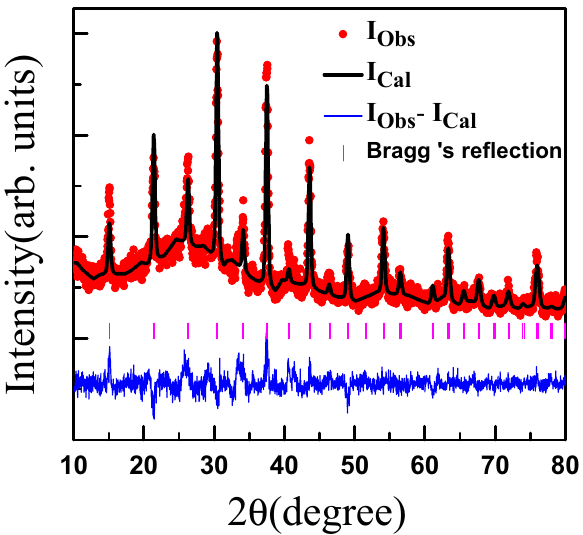
Figure 1. X-ray diffraction data (solid symbols) for as-grown (S0) Pd 3 Bi 2 S 2 film and it’s Rietveld refinement (solid curves through the data). The positions of the expected Bragg peaks are given as the vertical bars. The diference between the data and the refined pattern is shown at the